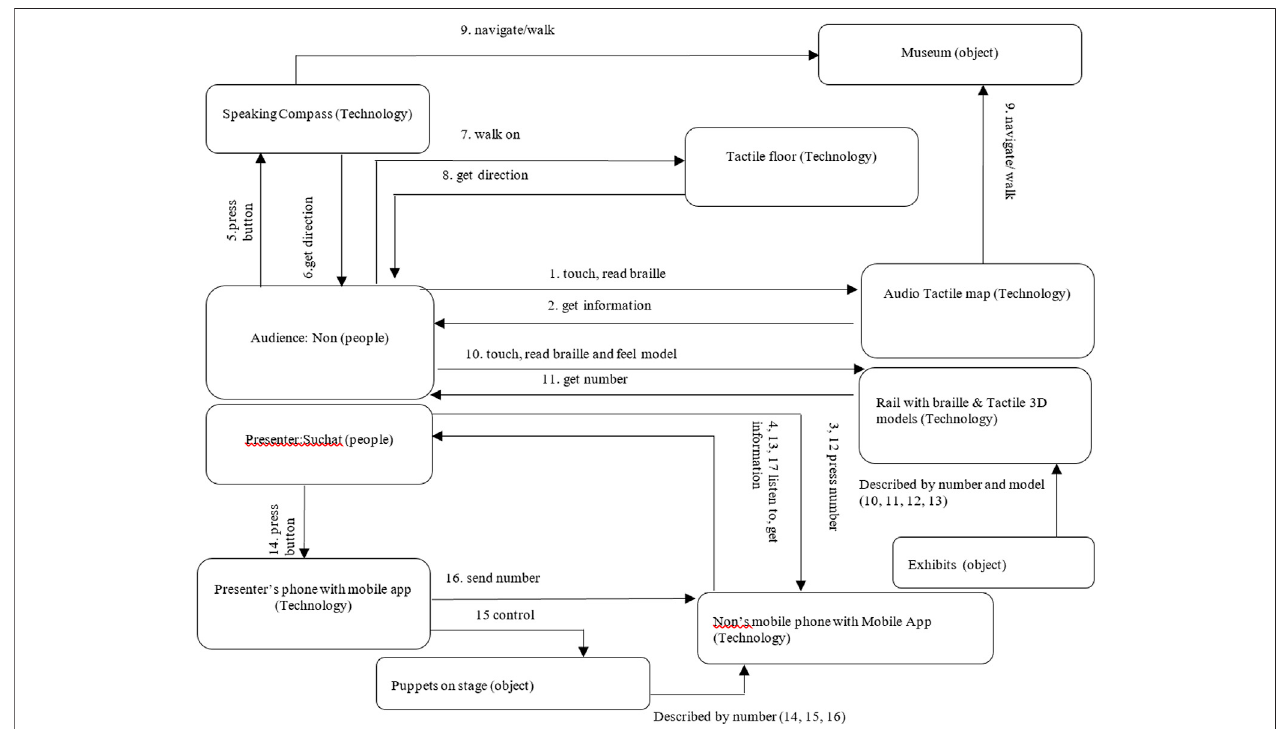
FIGURE 2 | Interaction diagram for a solution for Shadow Puppet Museum